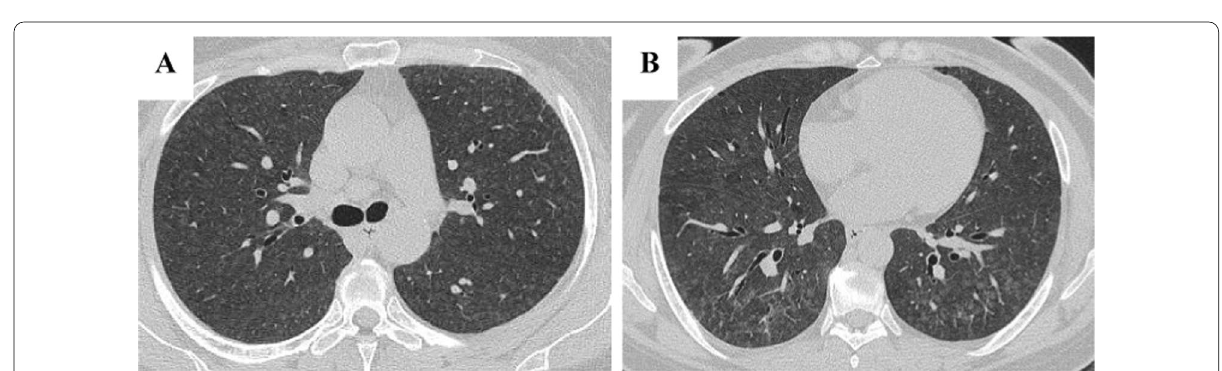
Fig. 3 A 44-year-old female complaining of progressive dyspnea and dry cough with history of raising birds. HRCT of the chest in a, b axial lung window images showing bilateral diffuse ill-defined ground glass centri-lobular nodules. The diagnosis of subacute hypersensitivity pneumonitis was